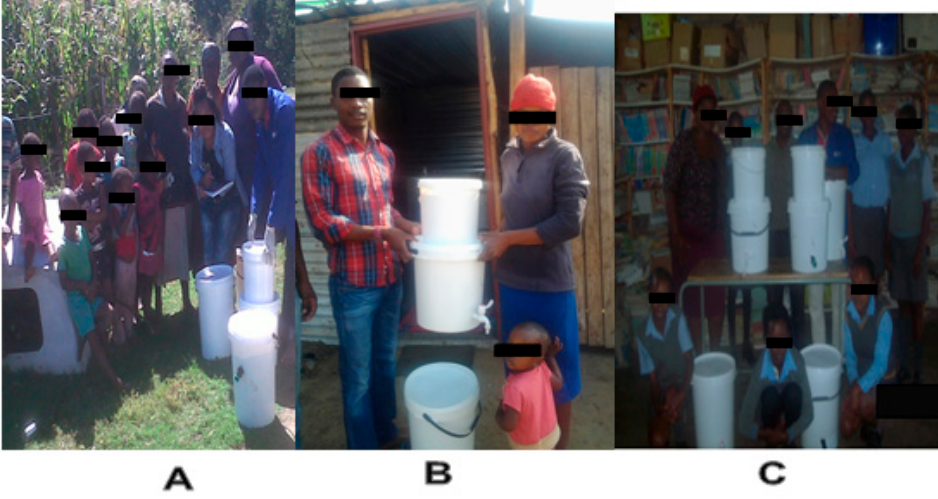
Figure 4. Deployment of the household water treatment systems (HWTS) devices in Makwane Village: ( A , B ) deployment in some of the households of Makwane community; ( C ) Deployment at a local primary school in Makwane Village.